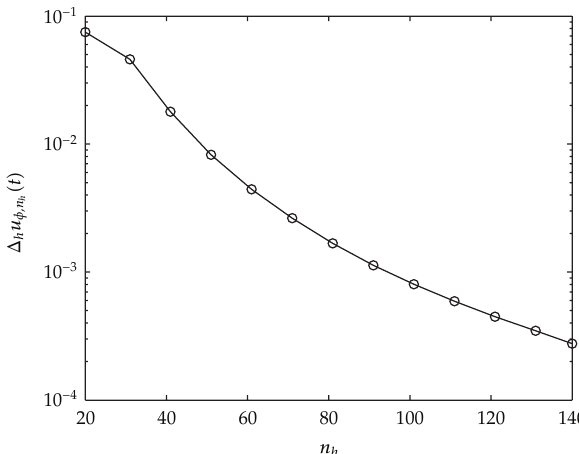
Figure 7: Error estimate (cid:4) 5.5 (cid:5) for one-dimensional case, for t (cid:2) 1 . 8, n φ (cid:2) 20, α (cid:2) 1 , 5, k (cid:4) t (cid:5) (cid:2) cos (cid:4) t (cid:5) , and b (cid:4) t (cid:5) (cid:2) e − t . Closed boundary conditions.